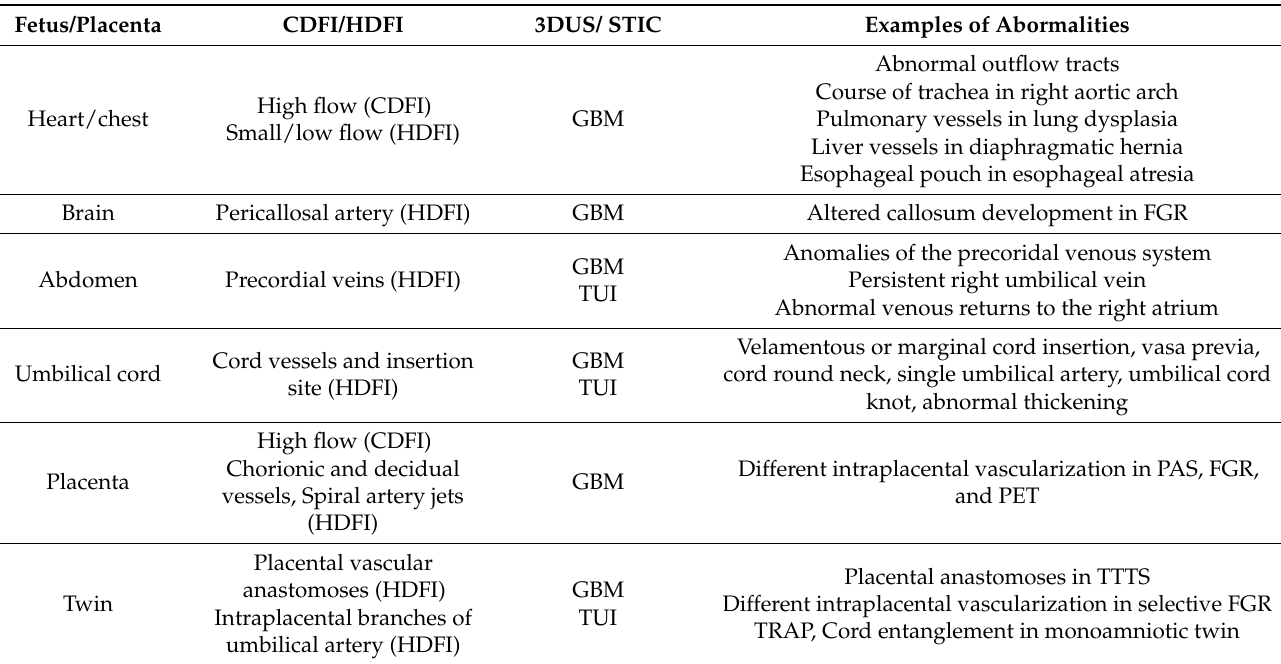
Table 3. Use of color Doppler flow imaging (CDFI)/ high-definition flow imaging (HDFI) with 3-dimensional ultrasonography (3DUS)/ spatiotemporal image correlation (STIC) in the prenatal evaluation of fetal cardiac and placental